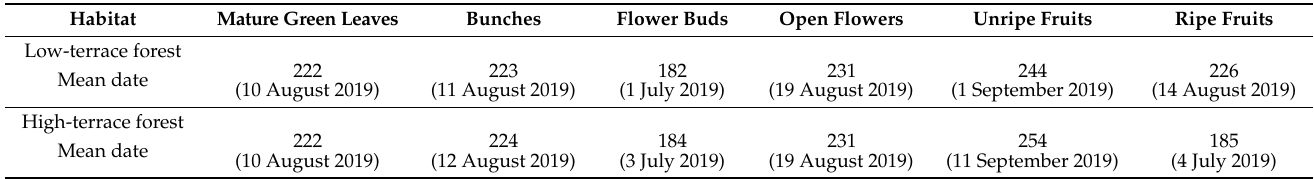
Table 3. Weighted mean of phenological variables in low-terrace and high-terrace forests of the Madre de Dios Region, Peru. Habitat Mature Green Leaves